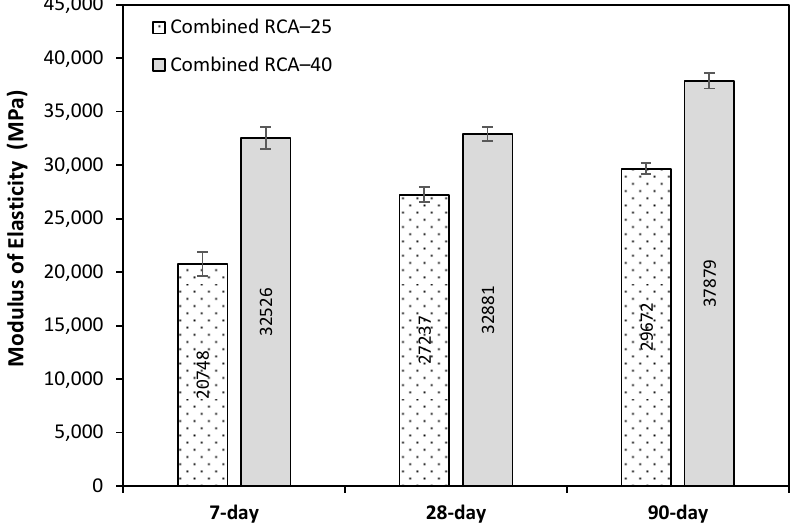
Figure 4. Modulus of Elasticity development of combined RCA concrete.